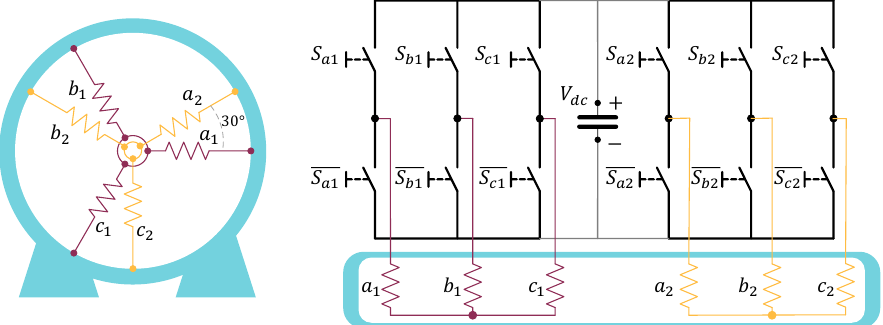
Figure 1. Asymmetrical six-phase induction machine fed by a dual two-level three-phase voltage- source